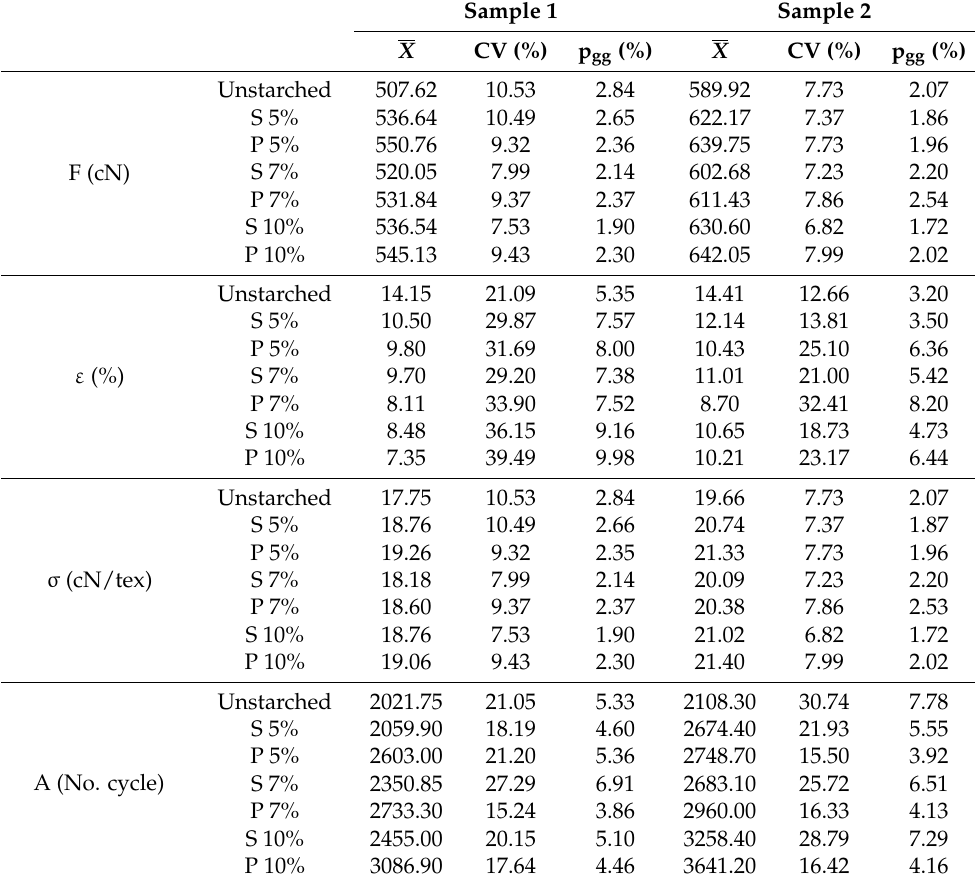
Table 5. Statistical indicators of the tested yarn values. Sample 1 Sample